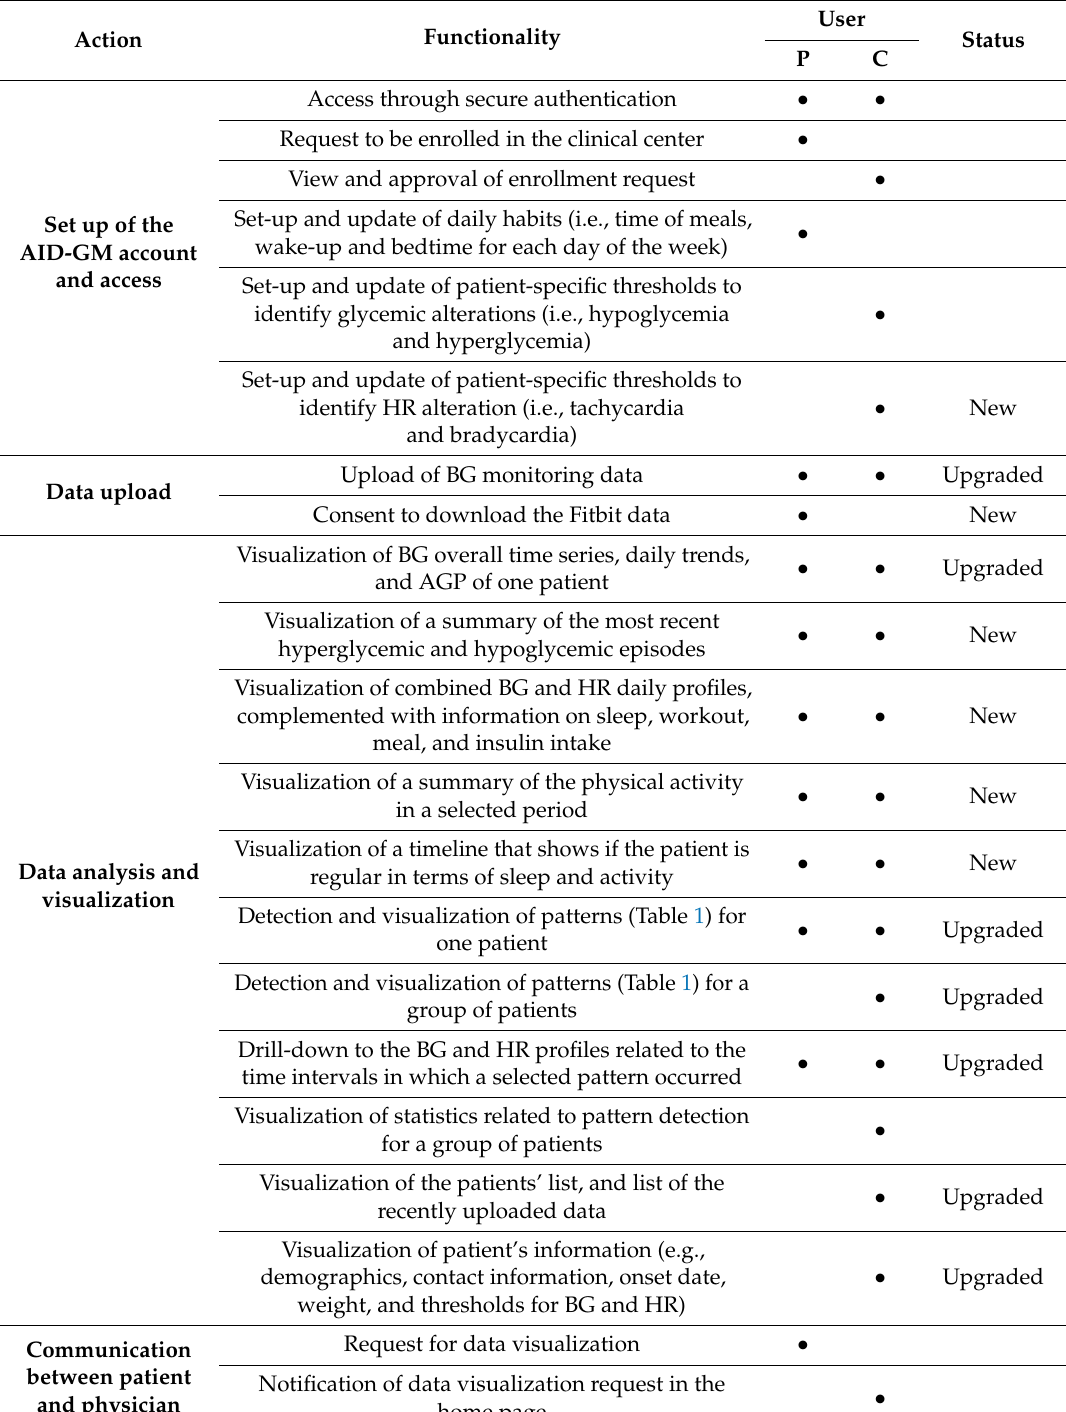
Table 2. AID-GM functionalities grouped by type of action. For each functionality, we provide the corresponding users, i.e., patient (P) or clinician (C), and the implementation status compared to the previous